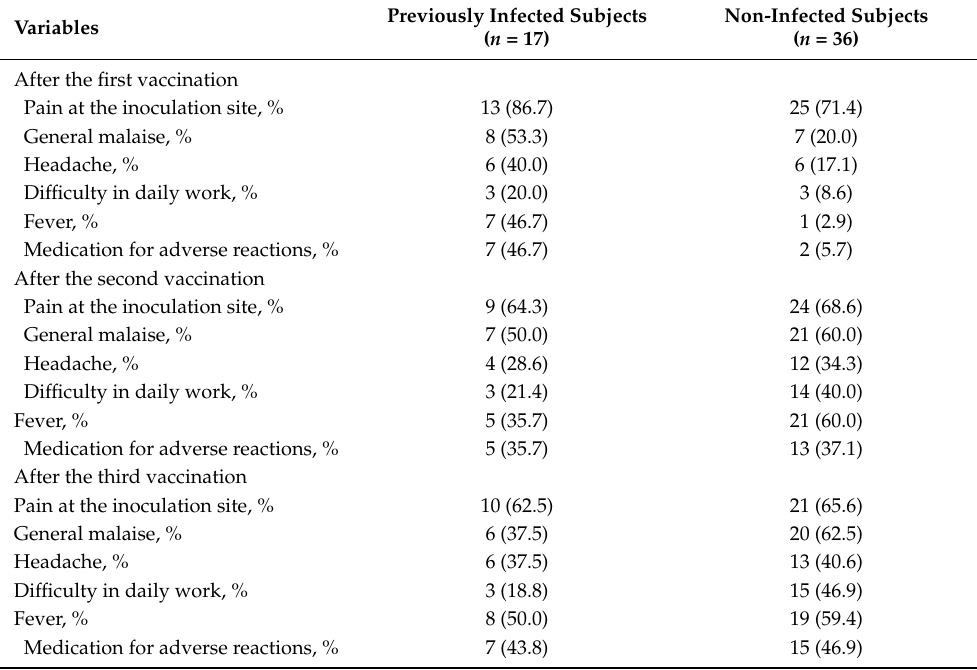
Table 4. Adverse reactions to